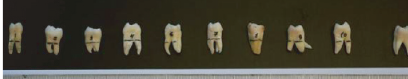
Figure 2: Sample selection of pluriradicular teeth and control group after cleaning and disinfection.